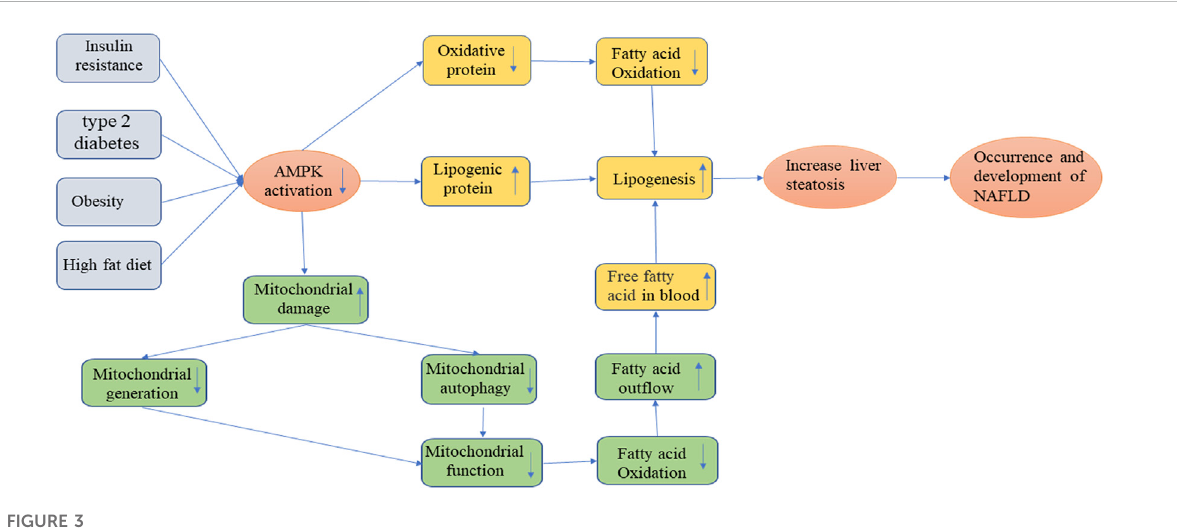
FIGURE 3 Occurrence and development of